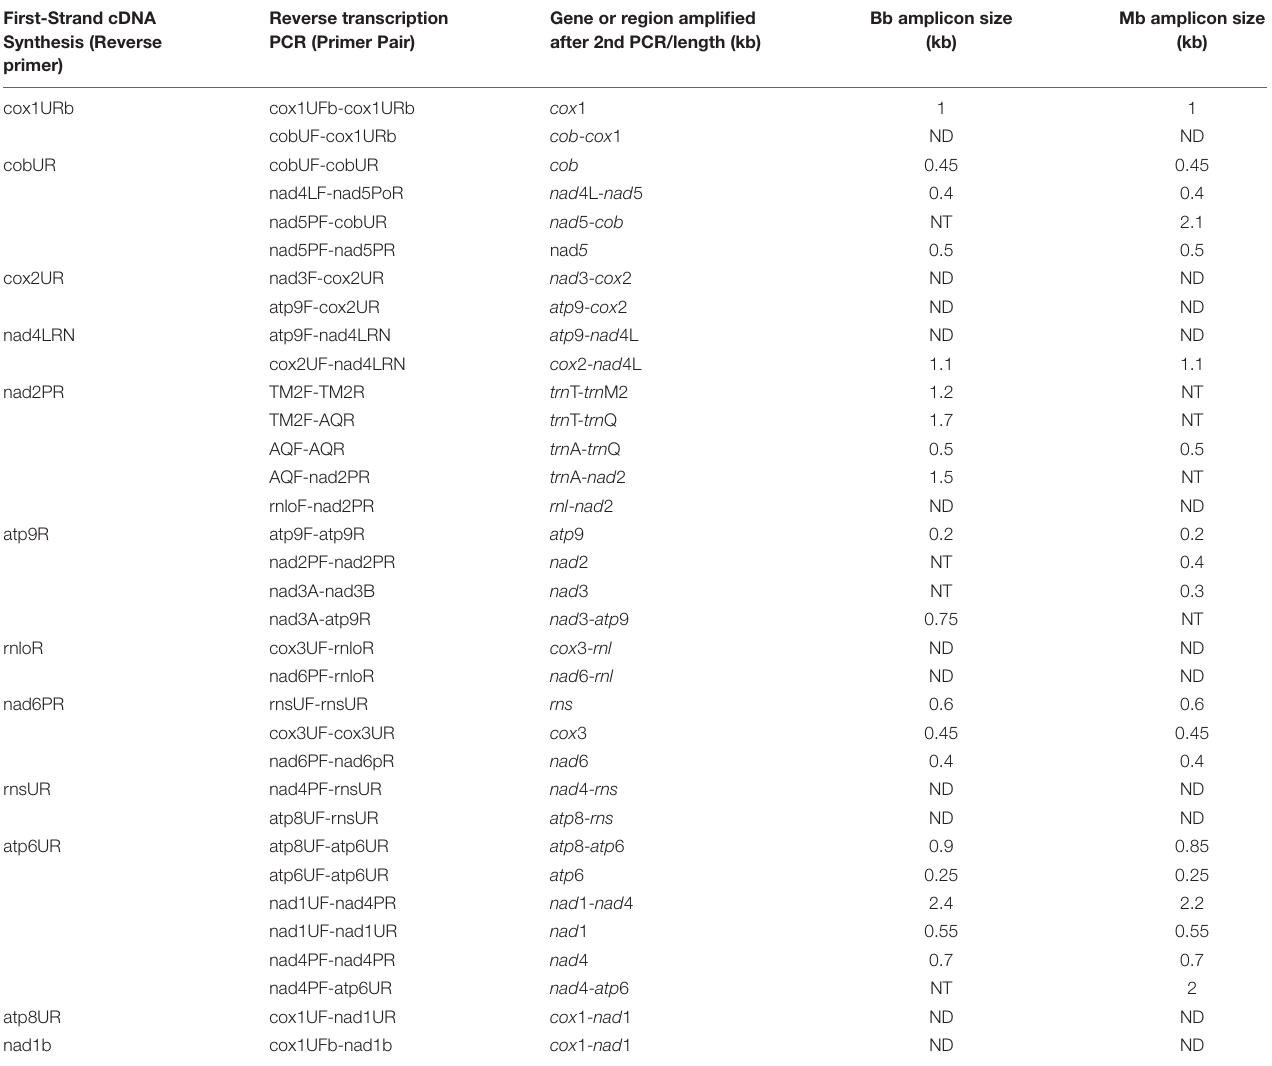
TABLE 5 | Amplicons produced with RT-PCR experiments, and their sizes after the PCR amplification in kbs. First-Strand cDNA Synthesis